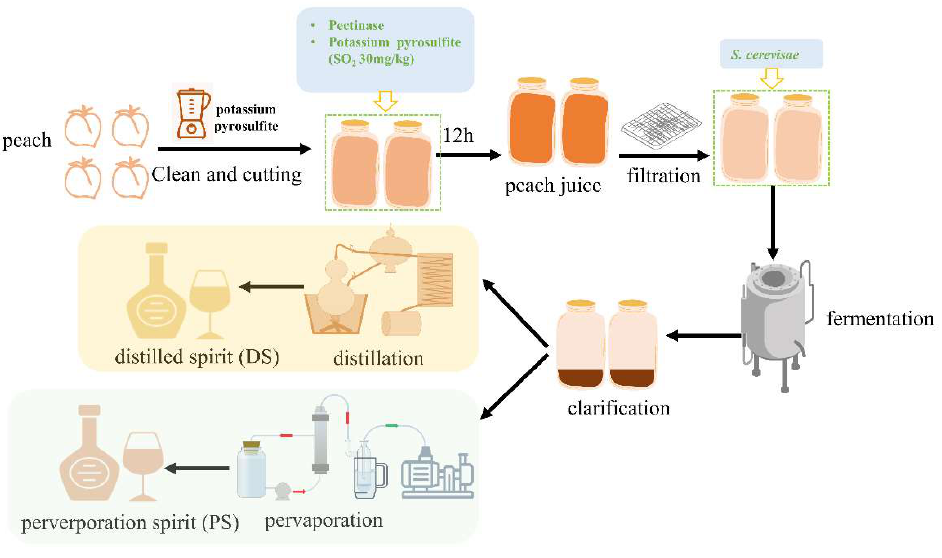
Figure 1. A process flow of DS and PS production.